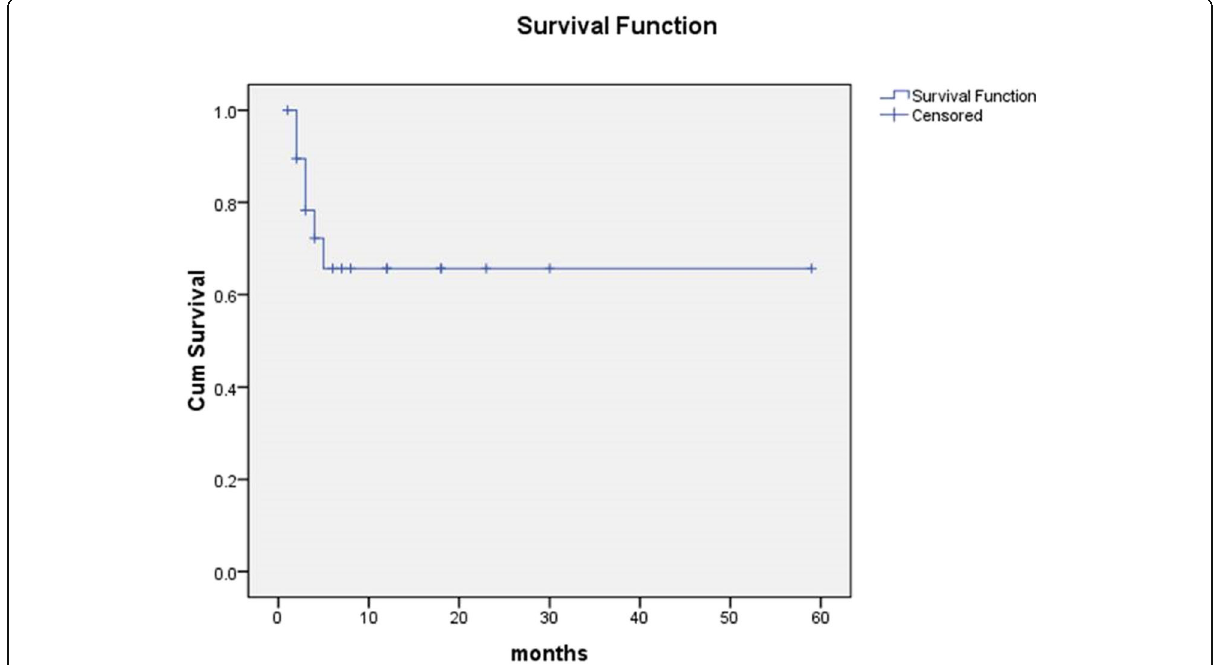
Fig. 1 Kaplan-Meier survival curve showing 5 years disease-free